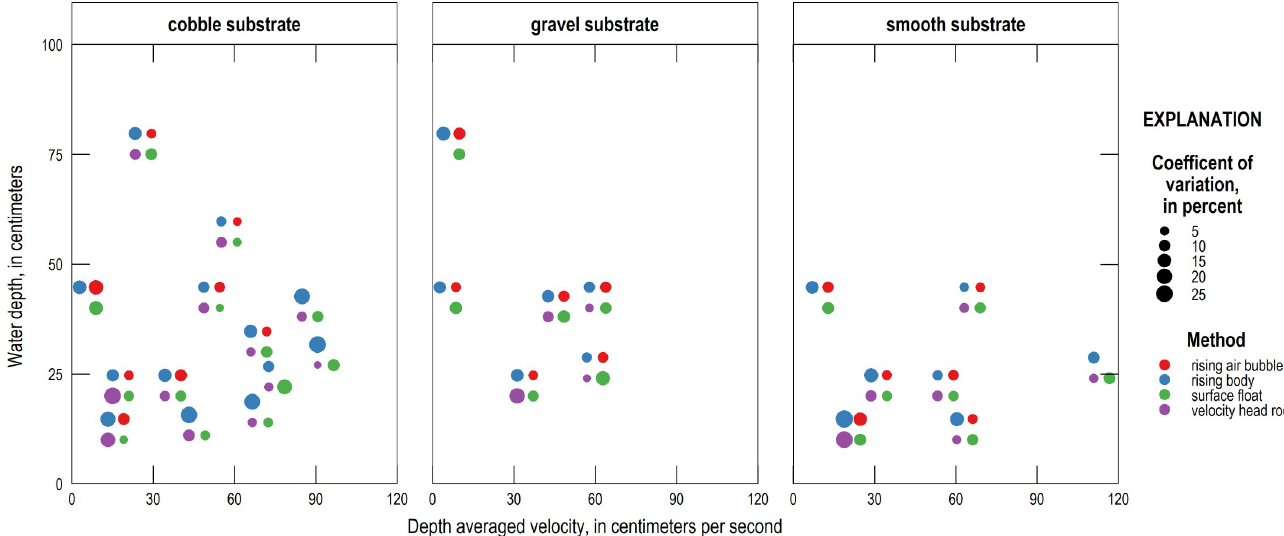
Fig 7. Relative precision, as measured by the CV, of the four alternative velocity methods under different conditions. Different colored circles represent different measurement techniques and the size of the circle represents the relative CV value, with larger circles showing less precision and smaller dots more. Each group of colored bubbles is centered on the coordinates representing the tested water depth and depth-averaged velocity. Individual bubbles are offset from this position, however, to avoid overlap.